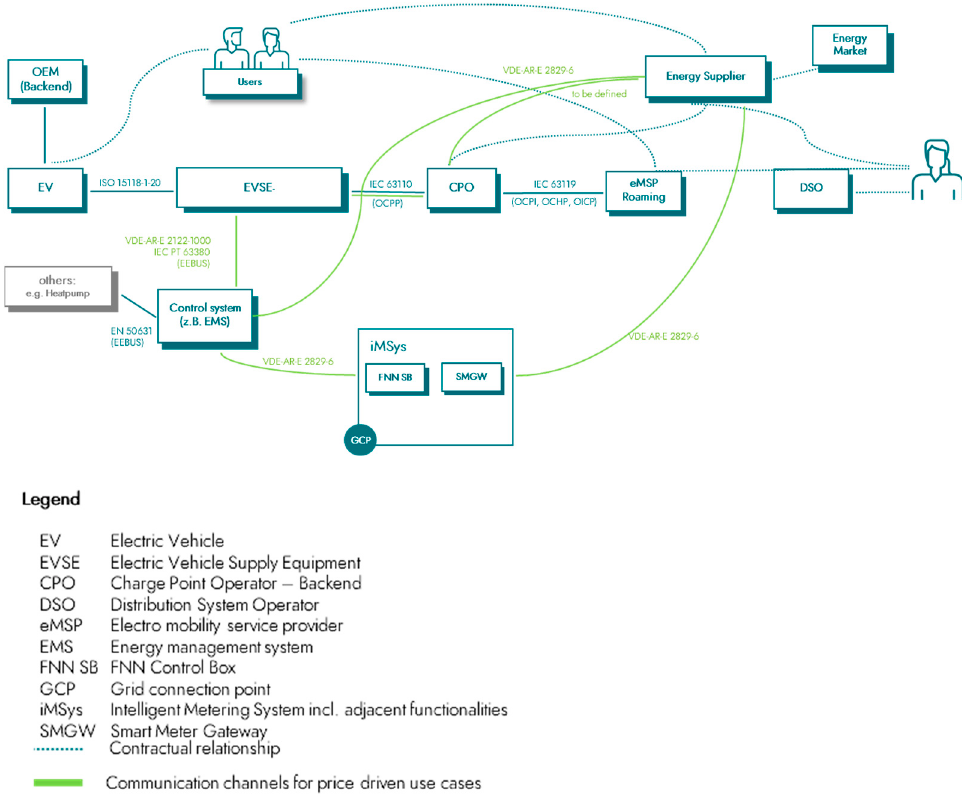
Figure 1. Smart charging system. Communication channels for price-driven use cases (green-coloured lines, upper graphic) and of emergency regulations via grid measures (red-coloured lines, lower graphic). In addition to the different communication channels in the respective use cases, the relevance of different standards depending on the use case is also shown.